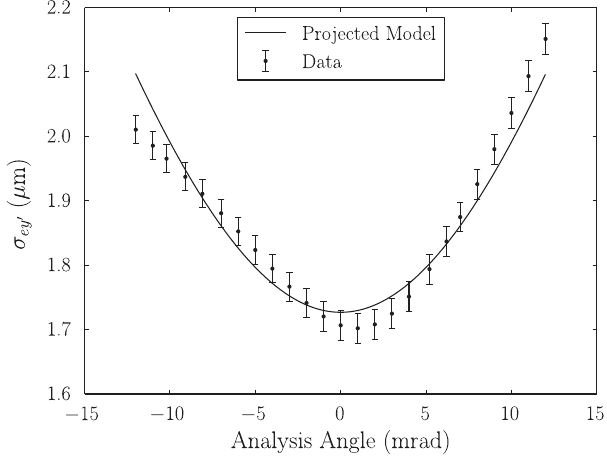
FIG. 26. Deconvolved vertical electron beam size as a function of analysis angle for combined multiple laserwire scans. The fit to a model of a projected bivariate Gaussian is also